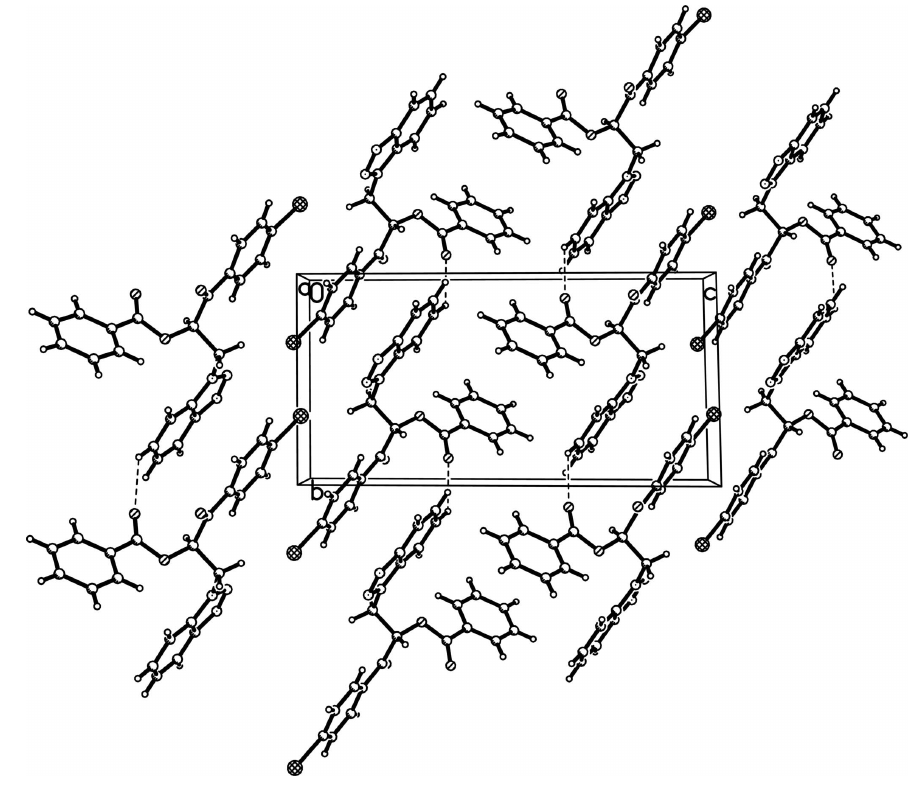
Figure 2 A packing diagram of (I), viewed down the a axis. Hydrogen bonds are indicated by dashed